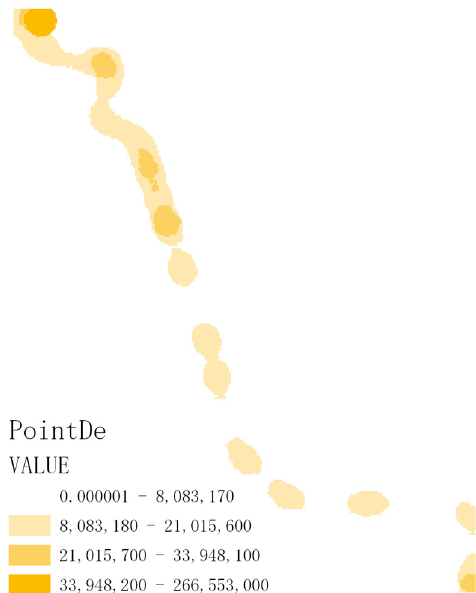
Figure 1. Analysis of point density.